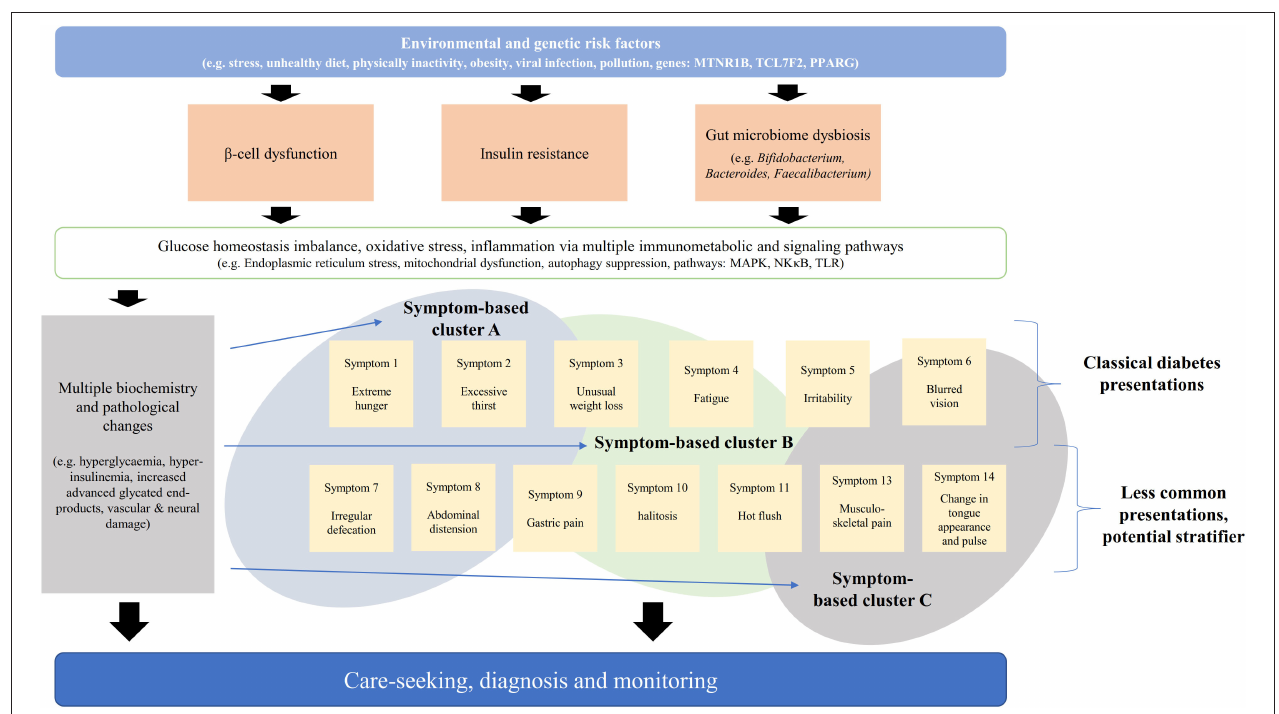
FIGURE 1 | Schematic diagram of association between pathogenesis, biochemical parameters, and symptoms. The pathogenesis of diabetes is multifaceted and symptomatic presentation could reflect the whole-system response.